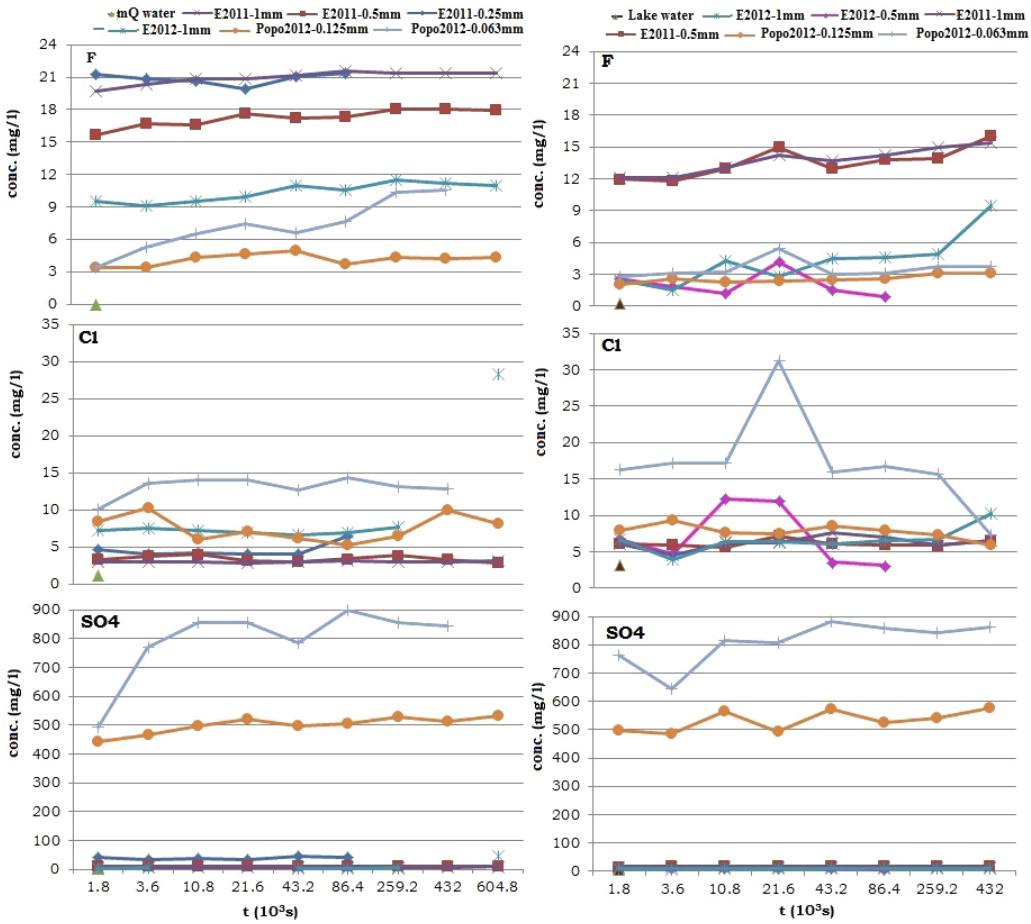
Figure 7. Anions’ (Cl − , SO 2 − , and F − ) variation of ash leachates in mQ (left column) and in lake water (right column) for variable stirring 4 times and different grain sizes. The different anions’ contents of mQ and lake water are reported for